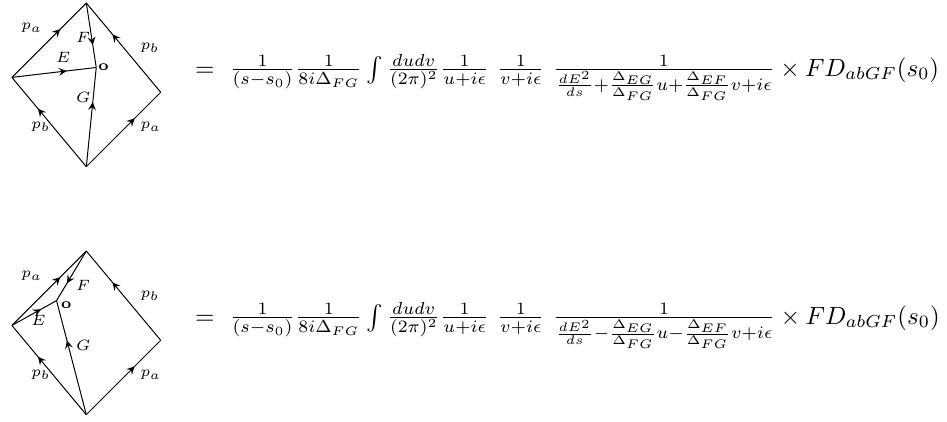
Figure 6 . On the first row is an example of a diagram that could in principle contribute to the pole at order ( s − s ) − 1 but it is zero. This is because all the simple poles in the u - and v -variable 0 lie in the same half-plane, since E is a positive linear combination of F and G . The diagram on the second row instead contributes to the pole with a result different from zero. In both the expressions, FD abGF ( s 0 ) represents any tree level diagram with external insertions p a , p b , G and F which is finite at the position s = s 0